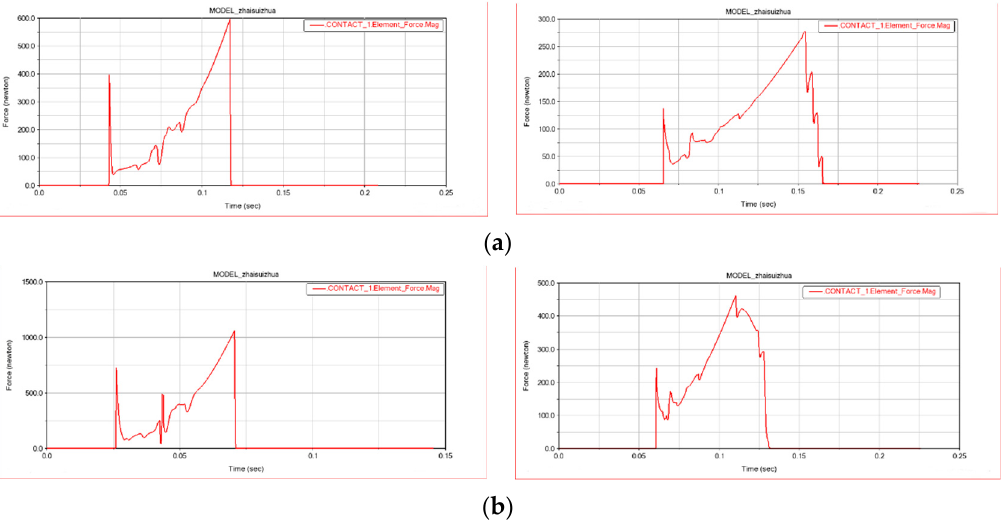
Figure 5. Contact force of ears at different claw picking speeds with a forward speed of 1.5 m/s. ( a ) Claw picking speed: 1.5 m/s; ( b ) claw picking speed: 2.5 m/s.